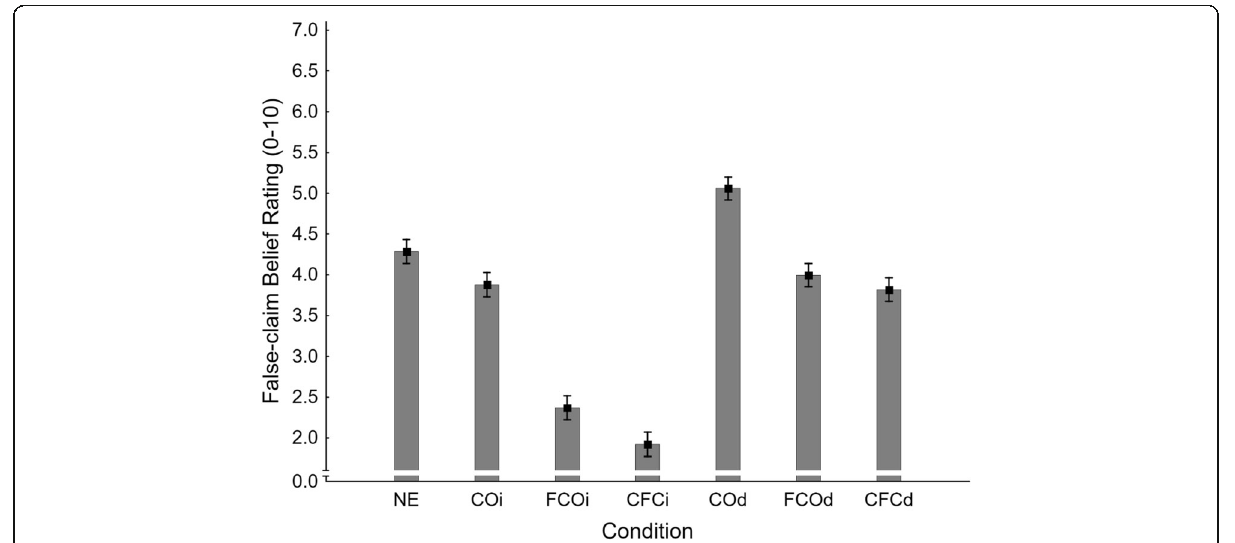
Fig. 8 Mean false-claim belief ratings across conditions NE (no-exposure), COi/d (claim-only, immediate/delayed test), FCOi/d (fact-check-only, immediate/delayed test), and CFCi/d (claim-plus-fact-check, immediate/delayed test) in Experiment 2. Error bars show standard errors of the